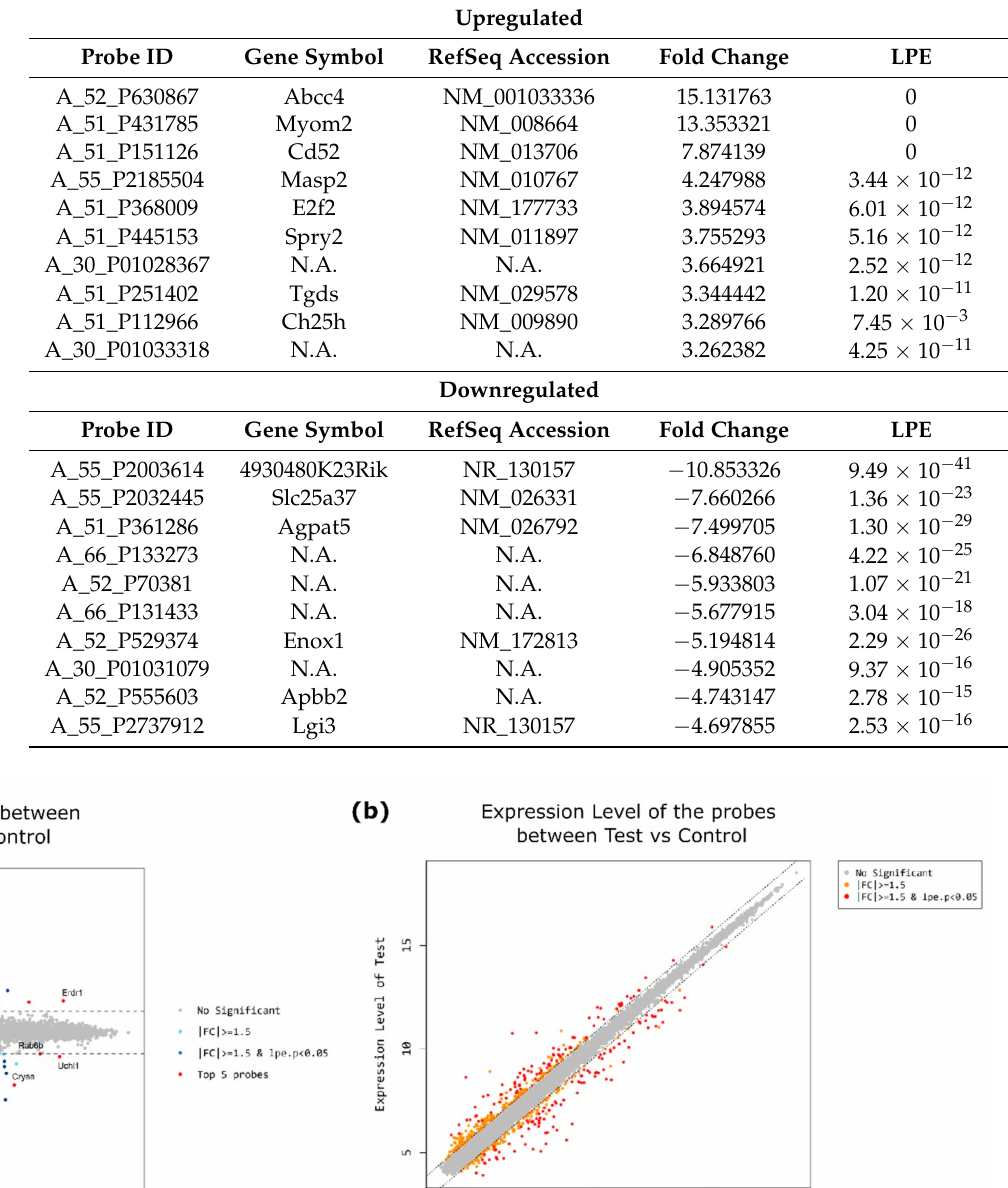
Table 1. The top 10 up- or downregulated probe list in the retina of aged Mrp4 knockout mice. LPE, local pooled error; N.A., not applicable.